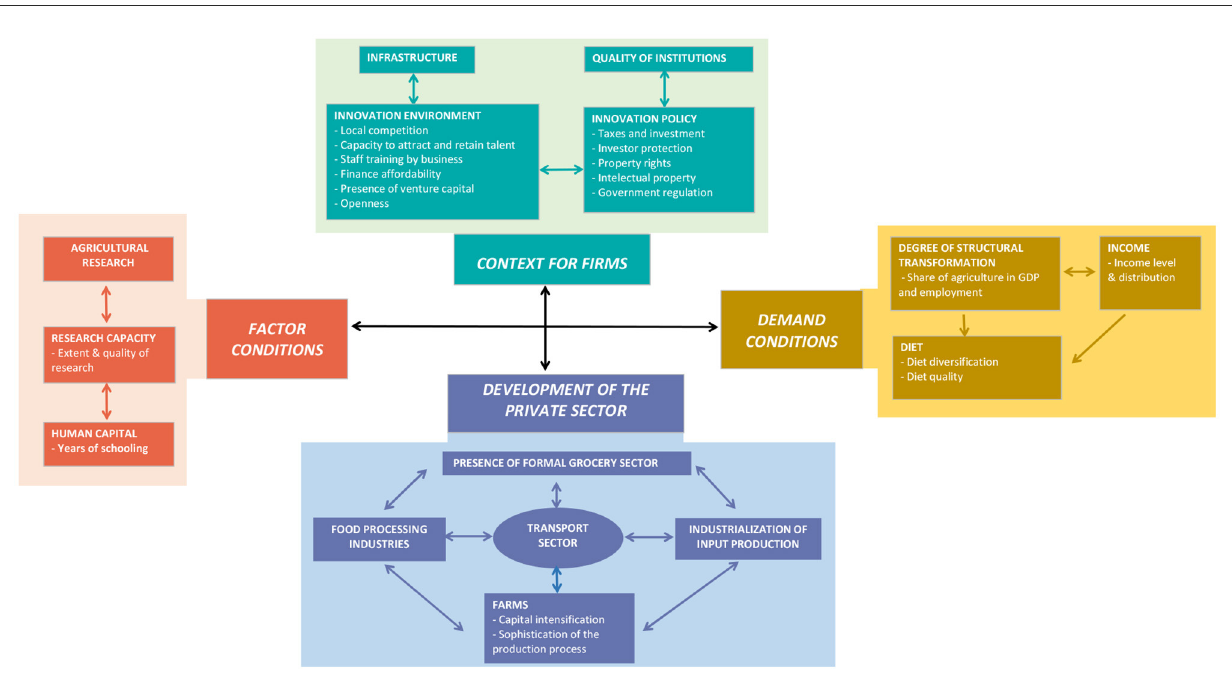
FIGURE5 The food system and the innovation context. Sources: Elaborated by authors based on Porter and Stern (2001), Spielman and Birner (2008), and Reardon et al.